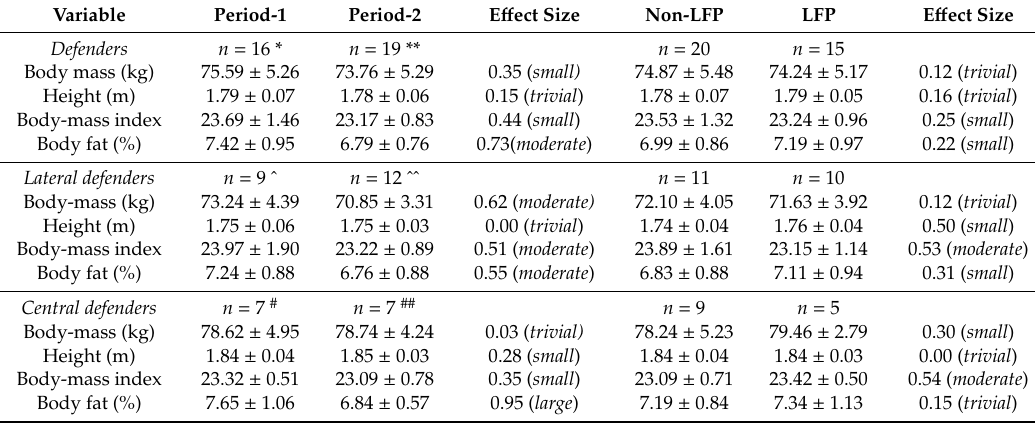
with that of defenders in Period-2 (2013 / 2014–2017 / 2018) and of Spanish non-LFP players with that of Spanish LFP players (2008 / 2009–2017 /